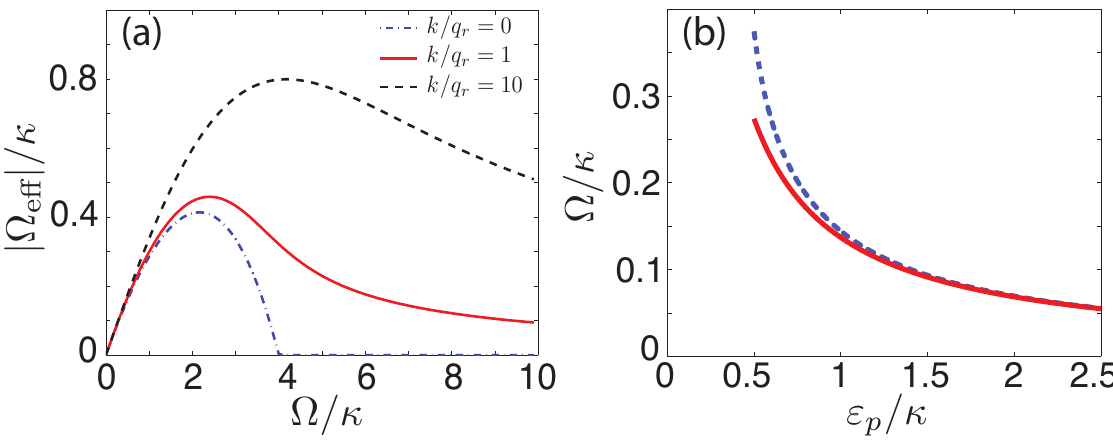
Ω is plotted as a function of atom-photon eff | | , 10 q for blue dash-dot, red solid and black r r Ω does not monotonically increases with Ω but rather eff | | limit, the two results match p